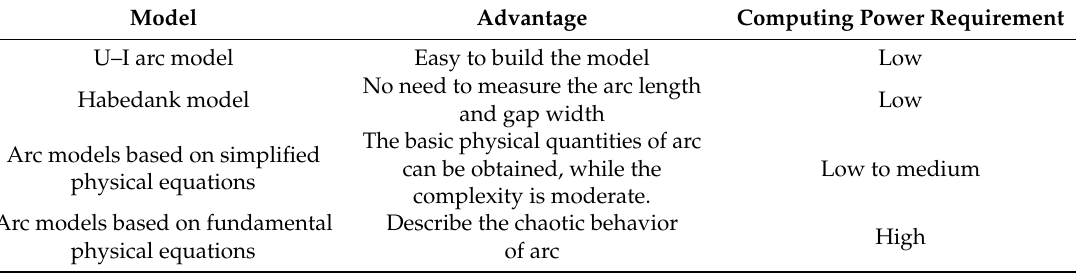
Table 2. Characteristics of di ff erent types of arc